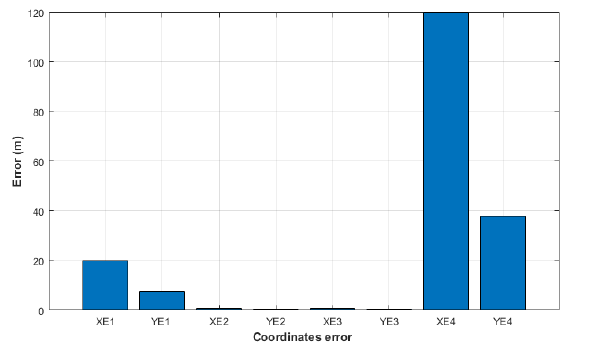
Fig. 7. Coordinates error in each initialization methods. 1. XE1 and YE1 : represent the sum error of the difference between the real coordinate ( 𝑥 and estimated one ( 𝑥𝑒 initialization 1.